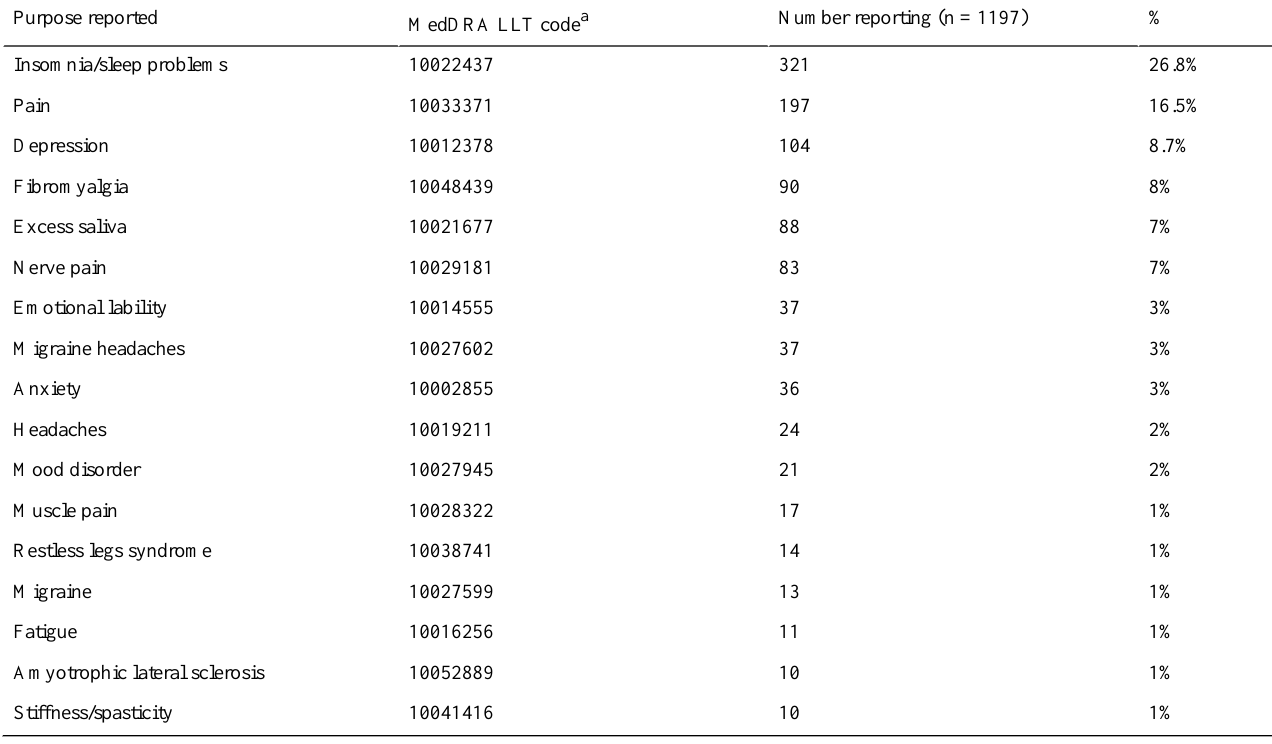
Table 3. Most common purposes reported for taking amitriptyline: purposes reported by 10 or more users are listed (n = 1197 purpose reports by 1394 users). The reasons people reported taking the drug vary